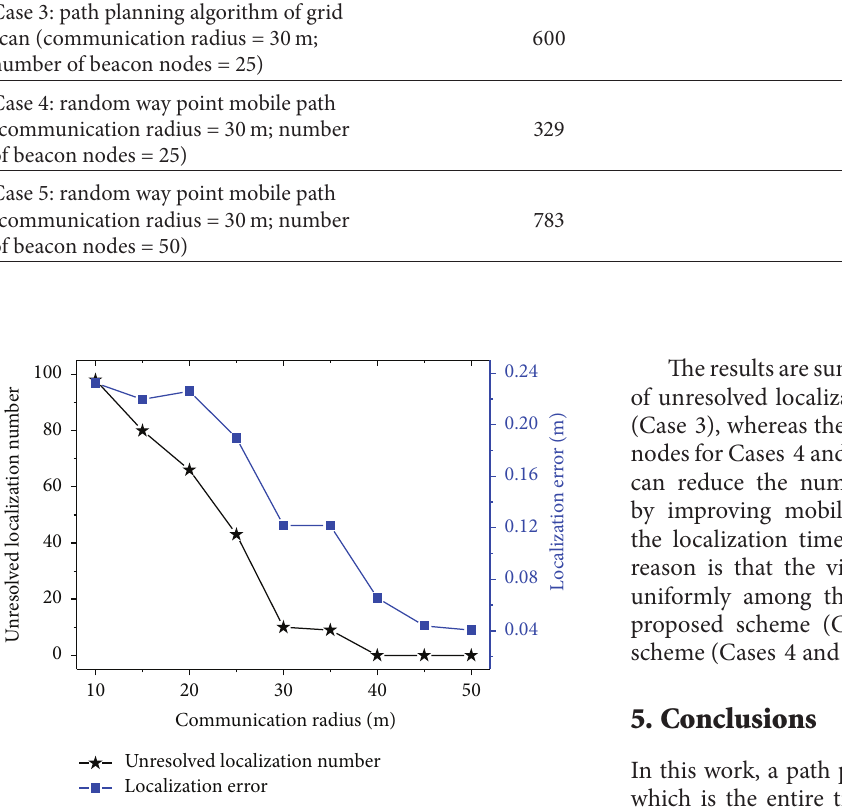
Figure 7: Relationship between localization effect and communica- tion